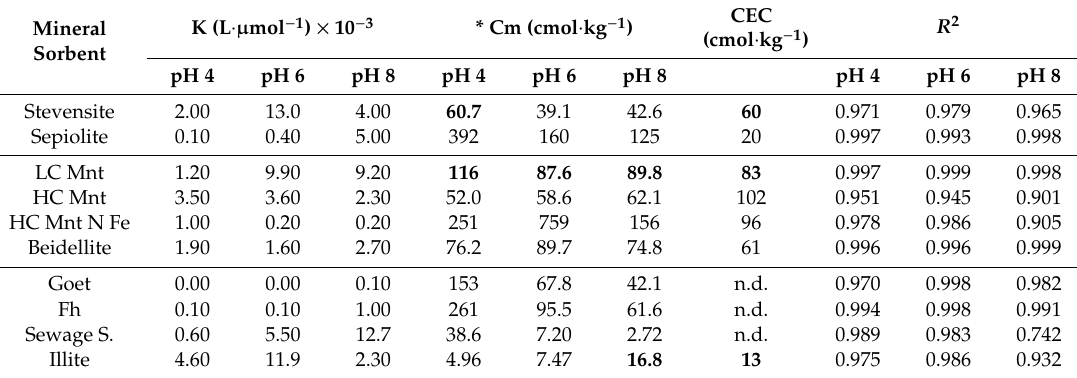
Table 4. Langmuir isotherm fitting